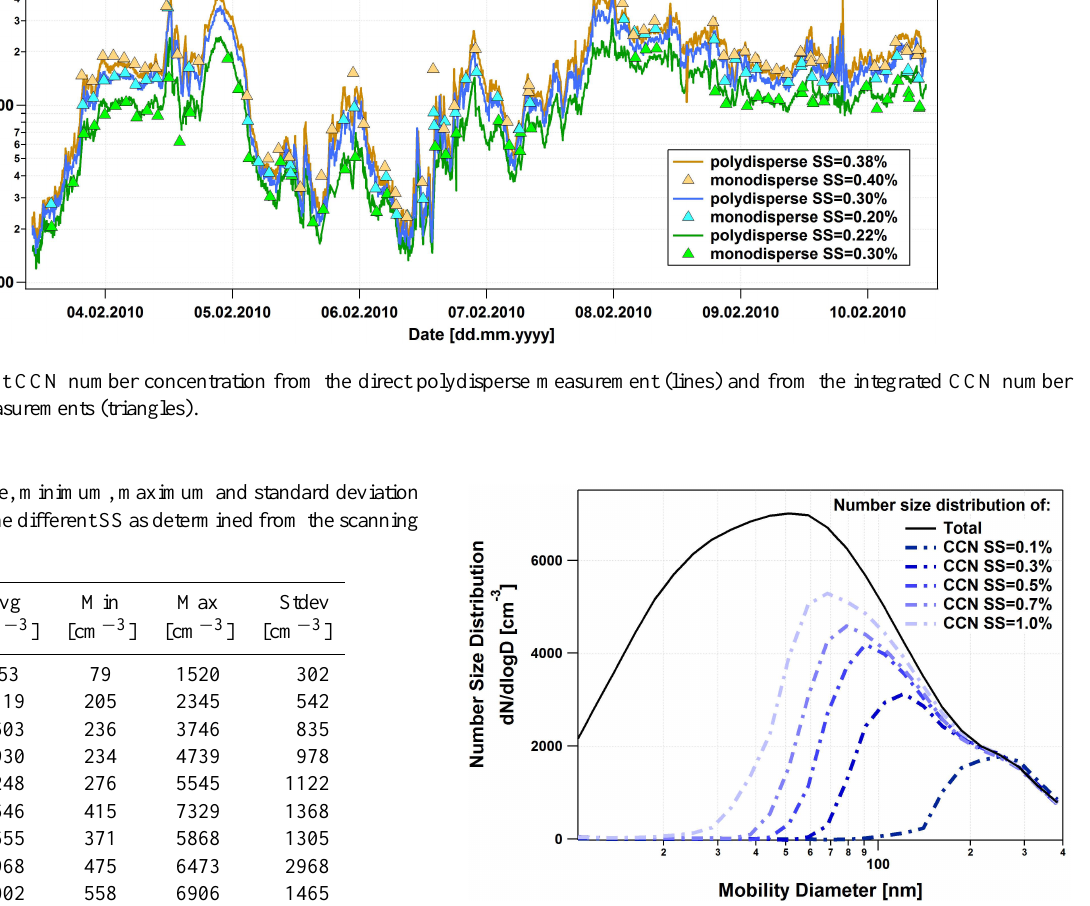
Fig. 5. Particle ( n(D) , black line) and CCN ( n CCN (D, SS ) , blue dashed-dotted lines) number size distributions averaged over the 10- days’ measurement